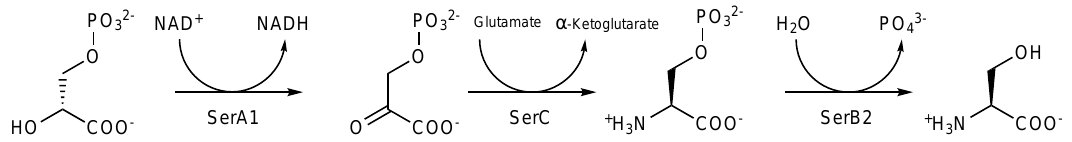
Figure 5. Representation of serine phosphorylated pathway of Mtb in which each step is catalyzed by a different protein. SerA, Phosphoglycerate dehydrogenase; SerC, Phosphoserine aminotransferase; SerB2, Phosphoserine phosphatase